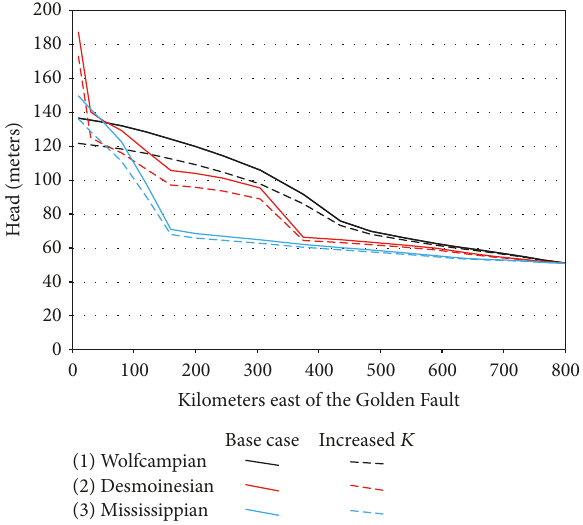
Figure 27: Sensitivity to increasing 𝐾 by 2 orders of magnitude in layers (1) , (2) , and (4) .